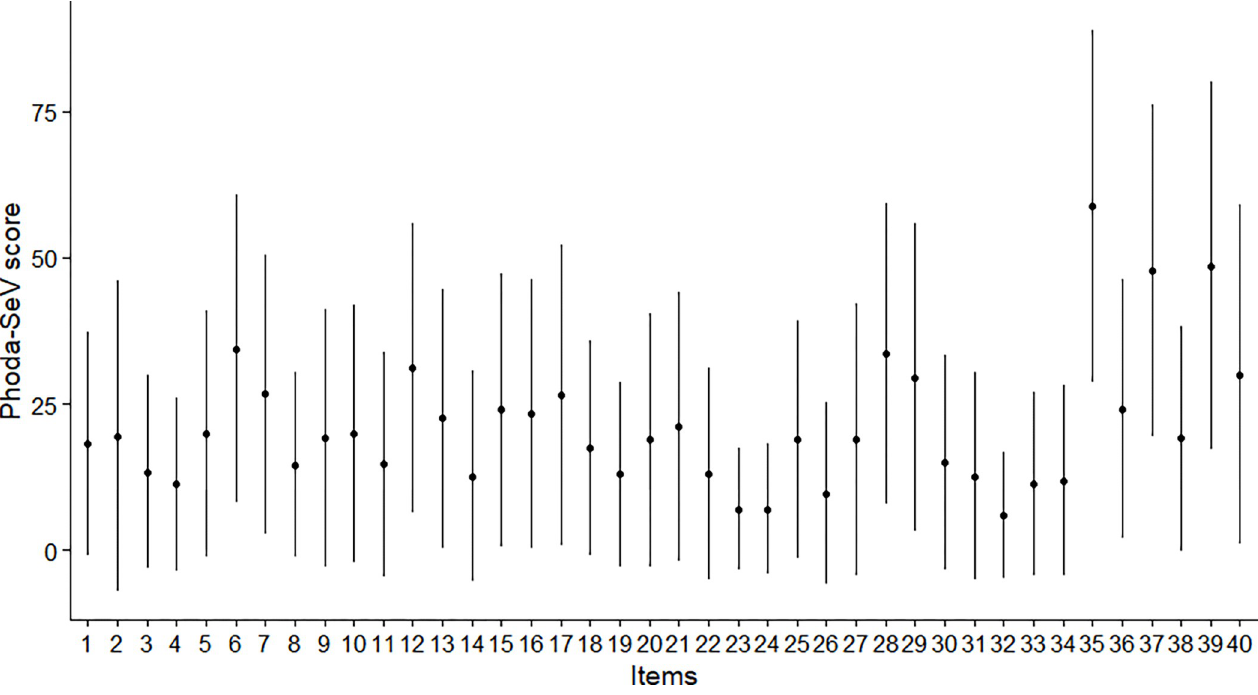
Fig 1. Mean with error bars as one standard deviation of the individual item scores of the PHODA-SeV.